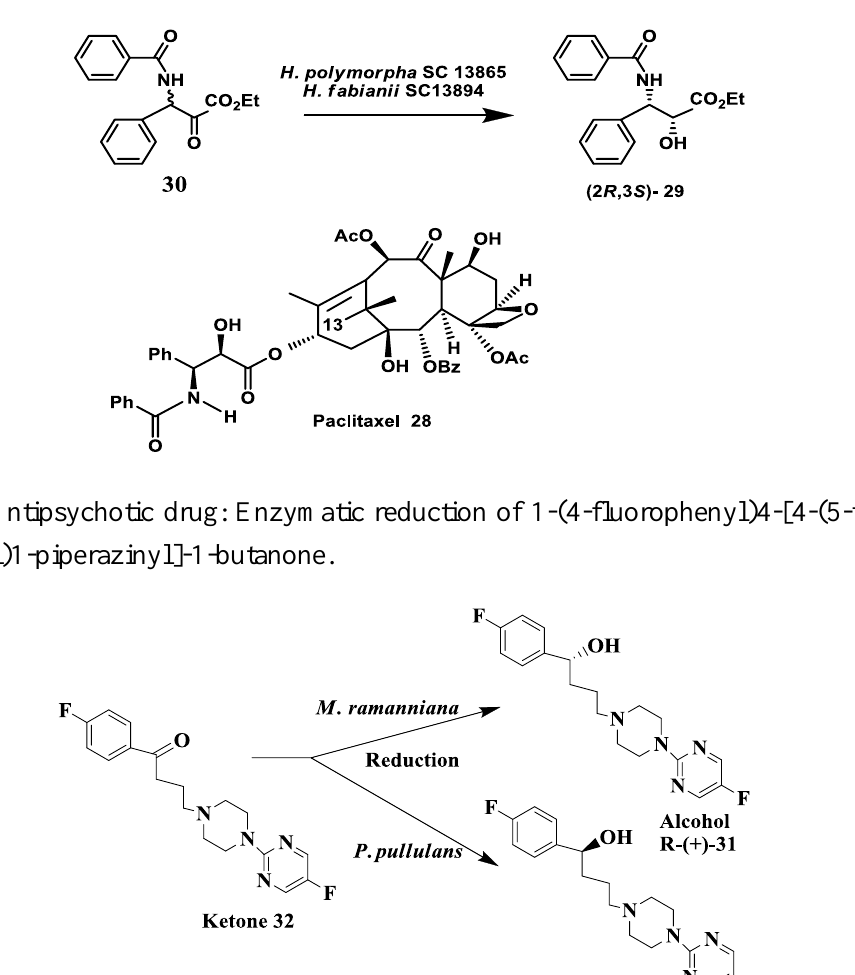
Figure 8. Anticancer drug: Enzymatic preparation of C-13 paclitaxel side-chain synthon.